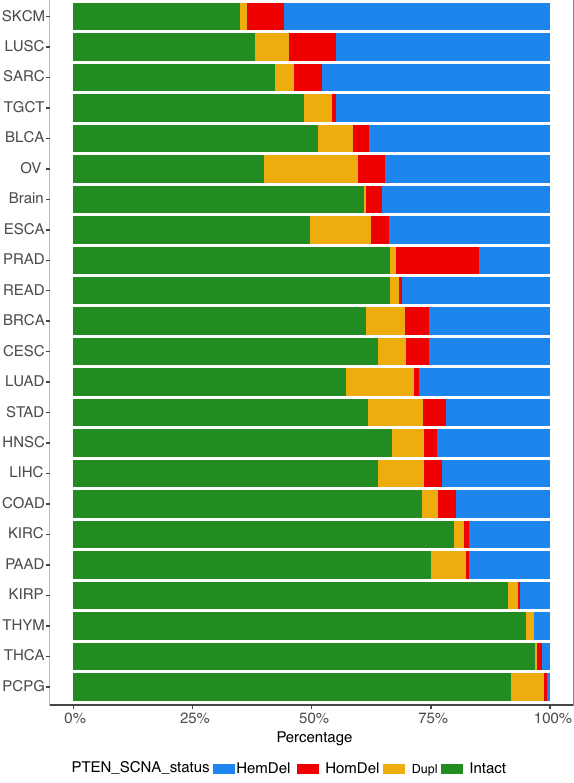
Similar hazard ratios were observed for TP53 monoallelic loss and PTEN HemDel, and there was no obvious additive effect when both mutations occurred together (Supplementary Table 2a). HNSCC tumors also showed similar hazard ratios for PTEN HemDel and TP53 monoallelic mutation without apparent synergy when both mutations were present (Supplementary Table 2b). These data suggest that one copy loss of either PTEN or TP53 results in equivalent effects on cancer outcome.